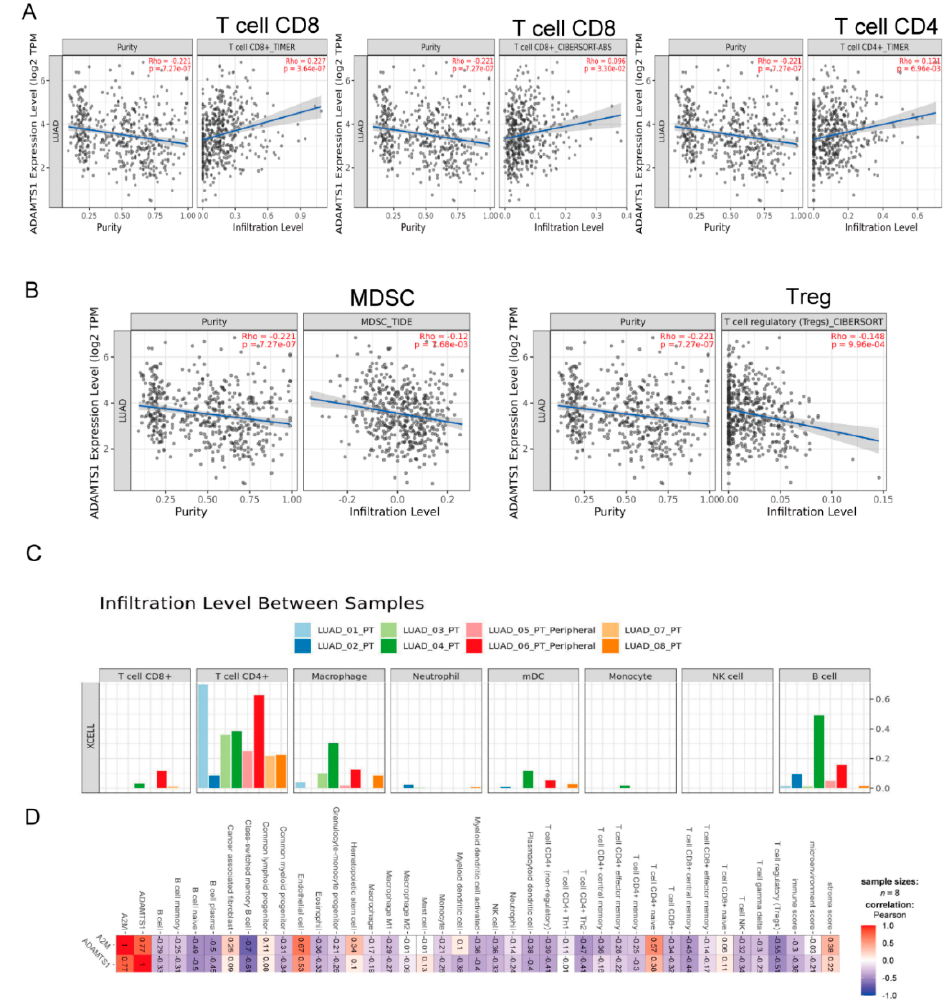
Figure 6. Correlation of immune or stroma score with ADAMTS1 and A2M in LUAD. Positive ( A )